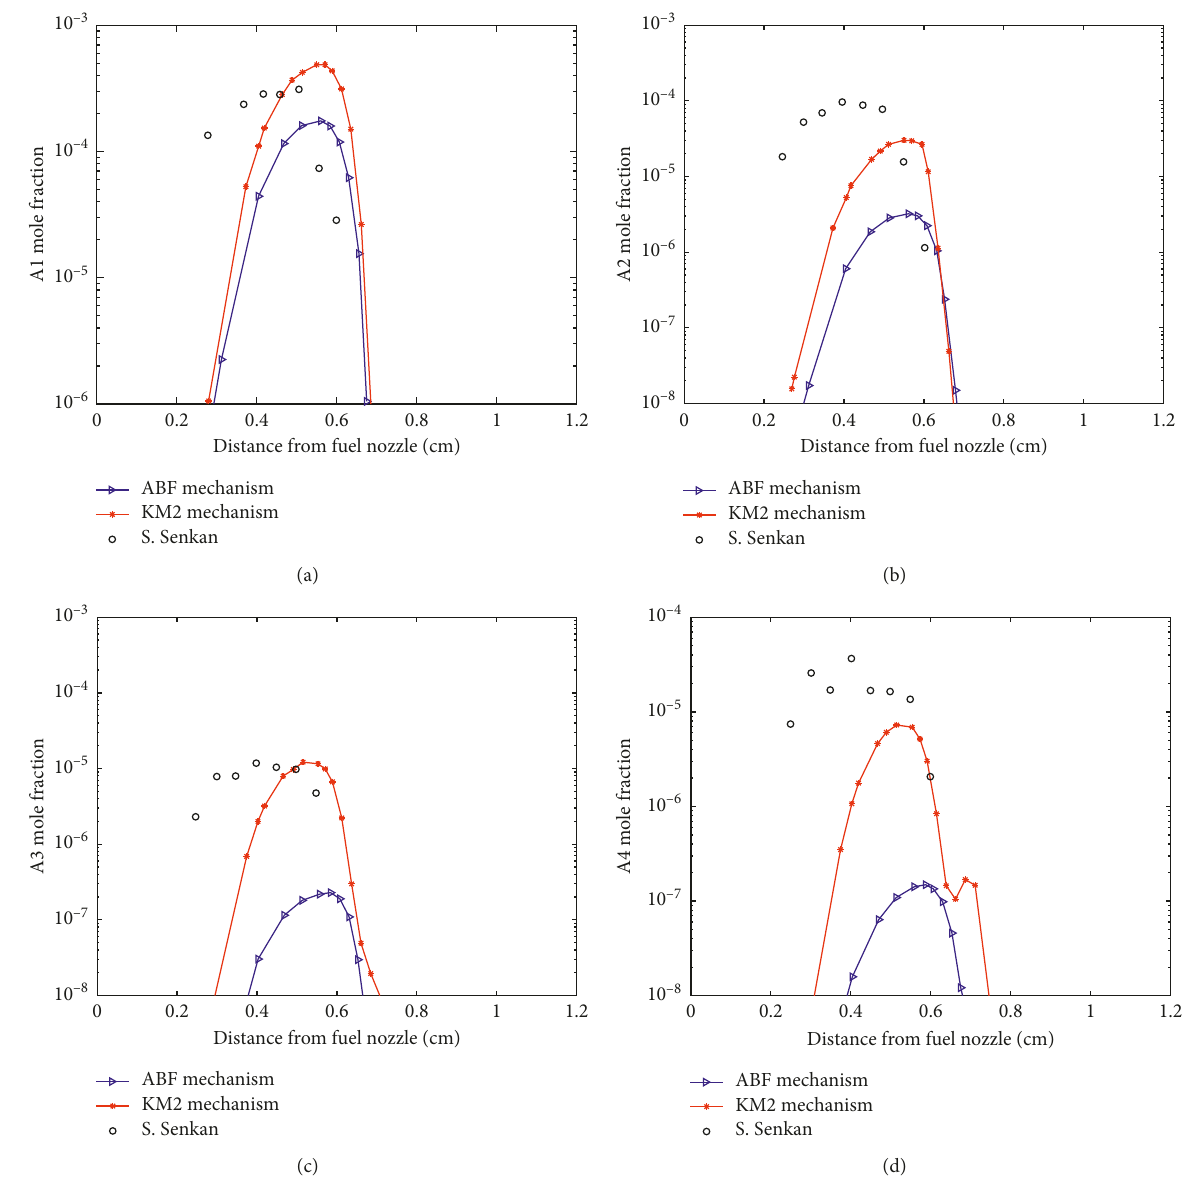
Figure 4: Profiles of A1–A4 mole fraction. Circles are measurement data from [29]. (a) A1, (b) A2, (c) A3, (d)